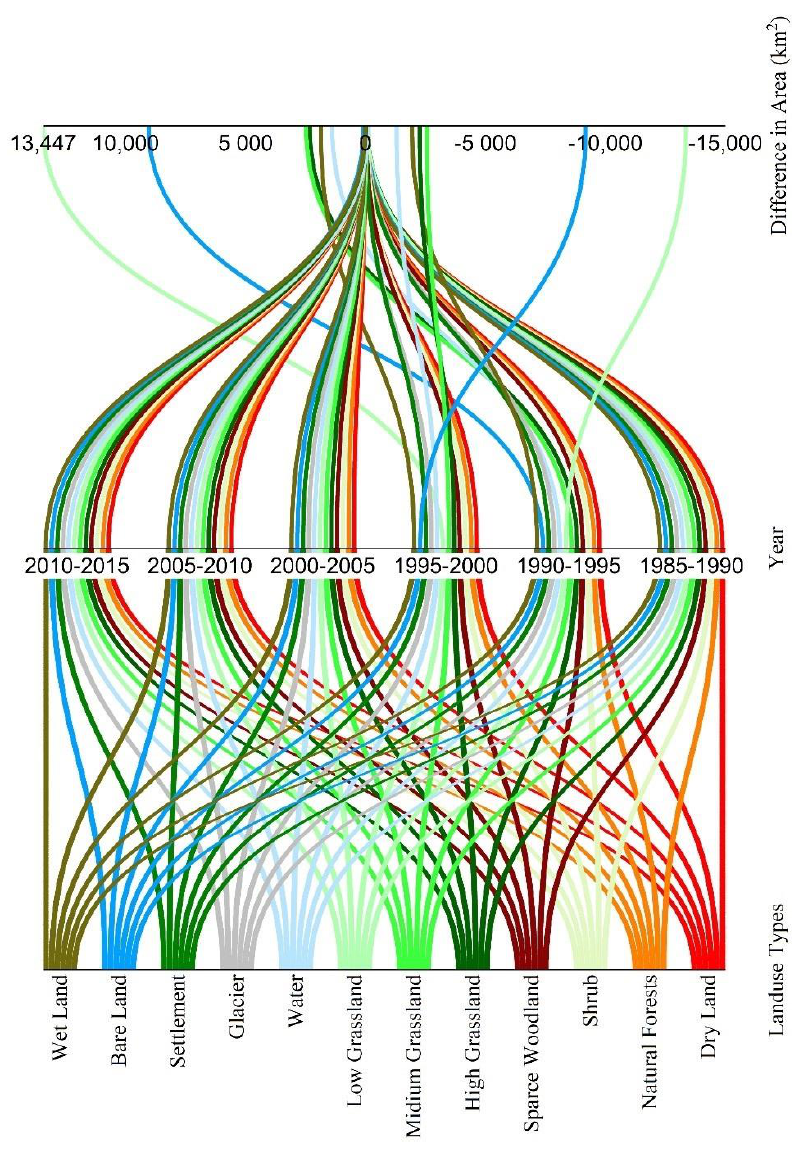
Figure 11. Area difference (km 2 ) of each land cover from 1985 – 2015 in the YRSR.